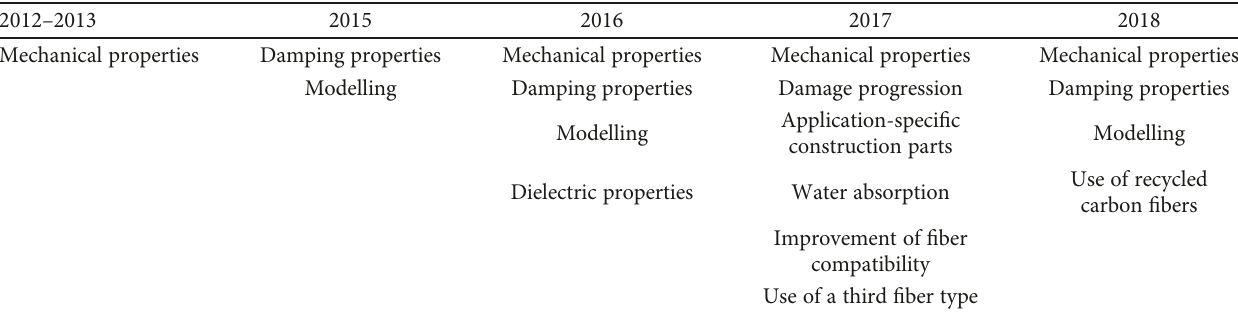
Table 2: Chronological summary of the studies on carbon/ fl ax polymer